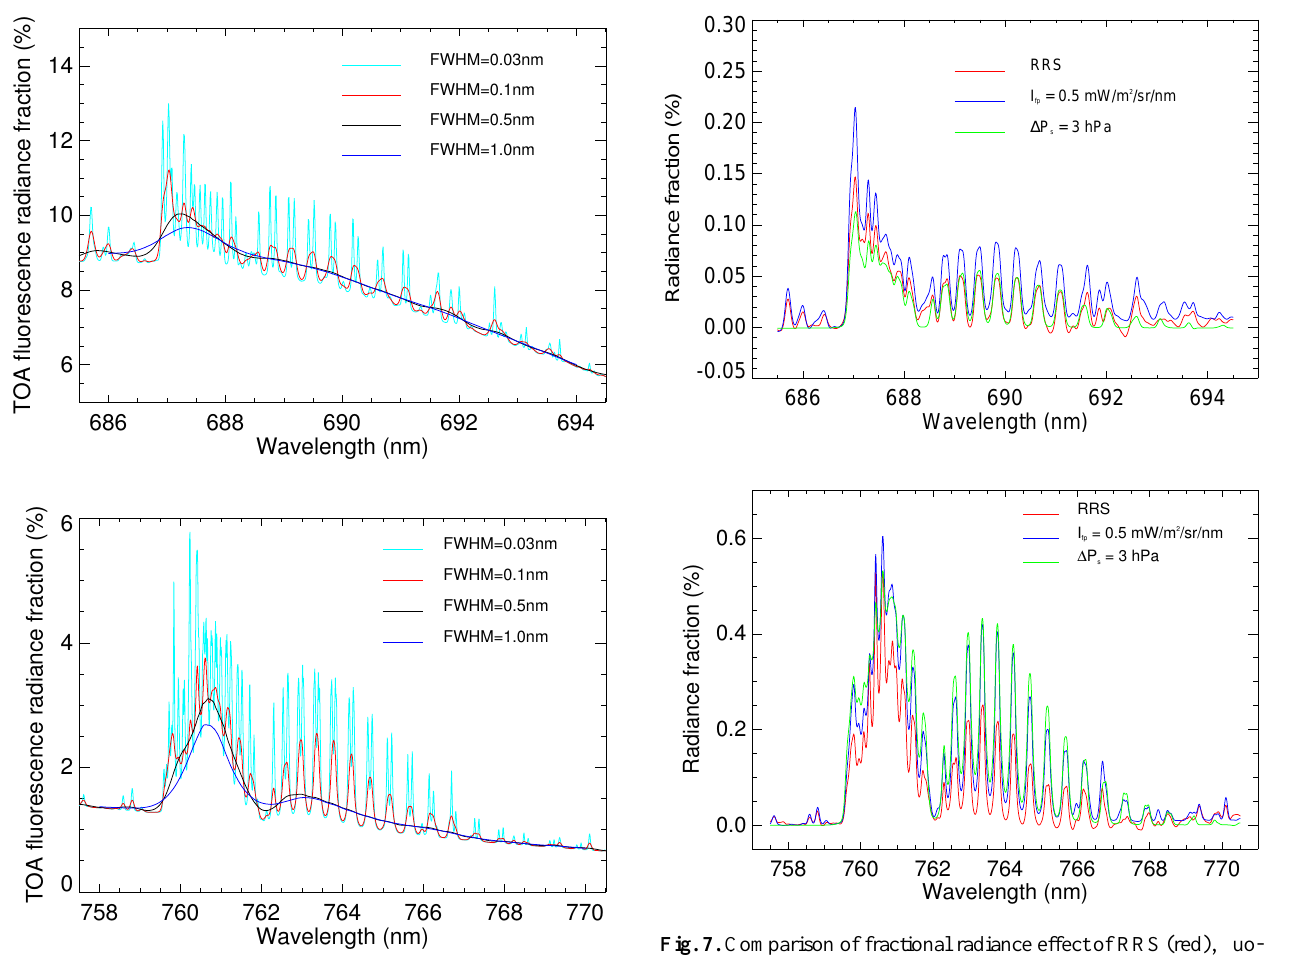
Fig. 8. Fractional inelastic radiance difference between aerosol loading with τ = 1.0 and aerosol-free case, SZA = 45 ◦ , at nadir, and surface reflectivity 0.3.